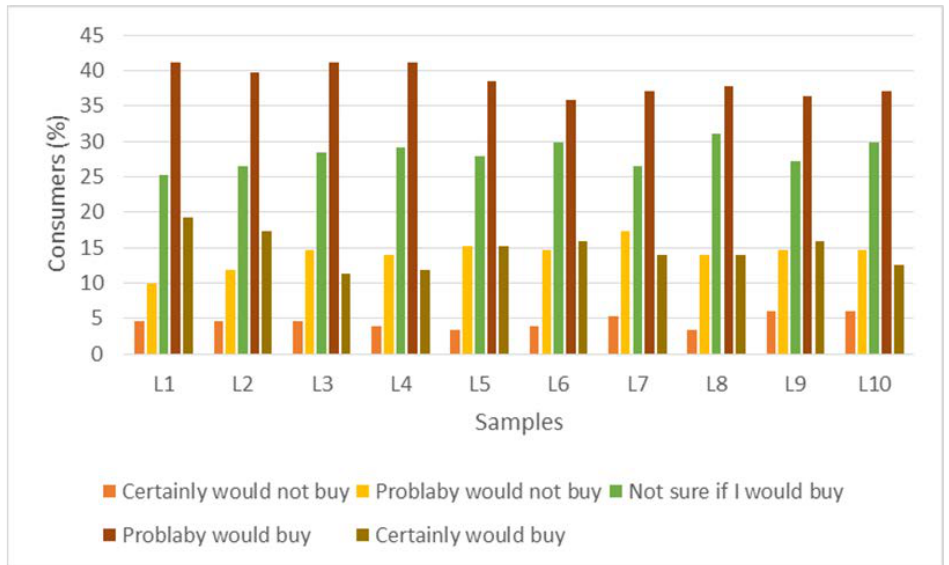
Figure 3. Histogram with the distribution of responses in the buying intention test for the label samples. L1 (Orange color label with sweeteners), L2 (White color label with sweeteners), L3 (Yellow color label with sweeteners), L4 (Blue color label with sweeteners), L5 (Green color label with sweeteners), L6 (Orange color label with sucrose), L7 (White color label with sucrose), L8 (Yellow color label with sucrose), L9 (Blue color label with sucrose), L10 (Green color label with sucrose). Each column represents the mean percentage frequency ([the number of participants who selected each term from the scale] × 100 / [the total number of participants]) for the ten labels.